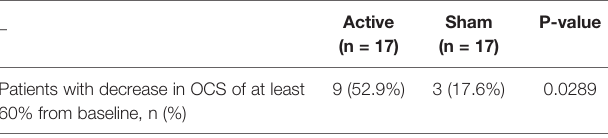
FIGURE 3 | Comparison of the percent reduction in the Opioid Craving Scale one week after the active and the sham treatments, using the OCS from week 1 before treatment as the baseline. The change after the active treatment, − 51.0% (SD 33.7) was signi fi cantly greater than that following the sham treatment, − 15.8% (SD 35.0), by a one-sided, Wilcoxon Test, **p = 0.004. Cohen ’ s ∂ was 0.73 for the active treatment over sham.